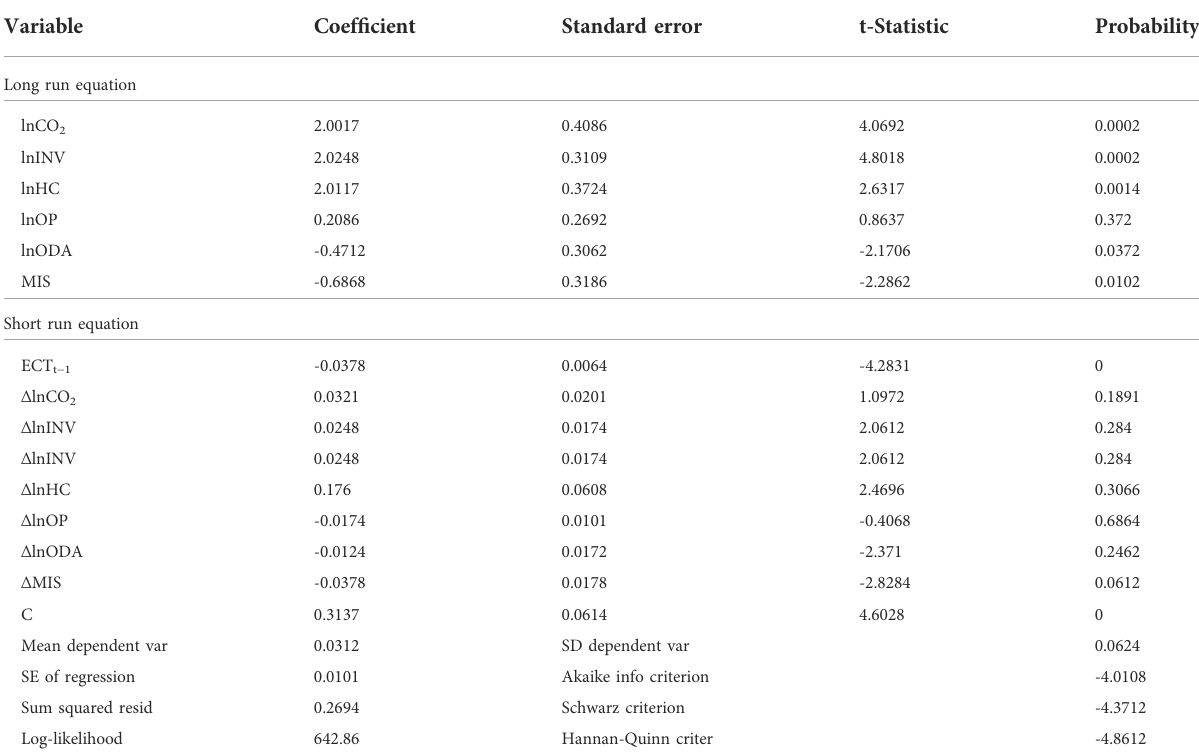
TABLE 8 The PMG/ARDL estimation results for the growth